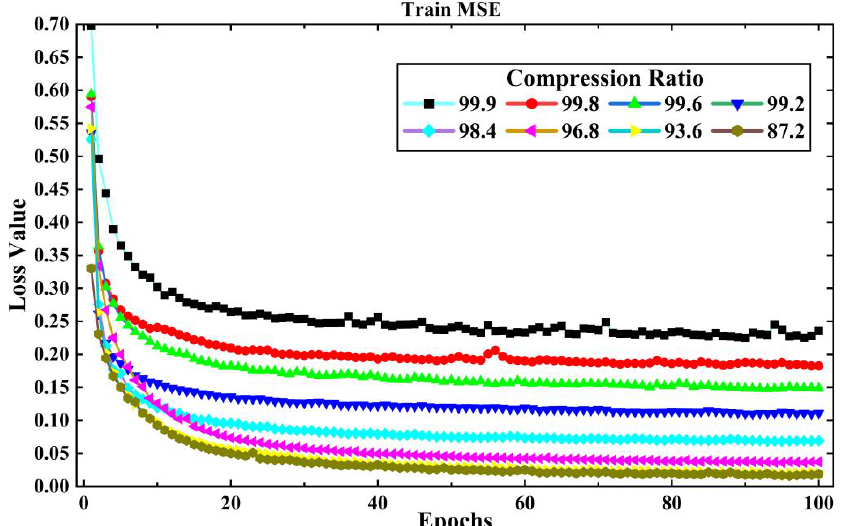
Figure 7. The changing of experimental loss value MSE with training epochs under different CR for a − CG lightning signal collected by the sensor array.